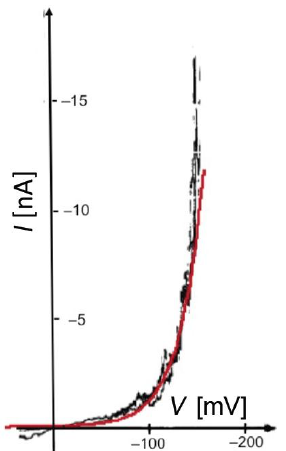
Figure 2. Experimental I-V curve for 0.4 μg/mL melittin in dioleoylphosphatidylcholine (DOPC), taken directly from Figure 7 of Pawlak et al. [20] (black curve), and curve calculated for a = 1 × 10 −4 , ∆ m = 70 D, θ 0 = 0.1, k N k R 2 = 1 × 10 6 s −3 and n = 1 (red curve). The height of the calculated curve was normalized to that of the experimental one. (Reprinted with permission from [38]. Copyright 2015, Elsevier).